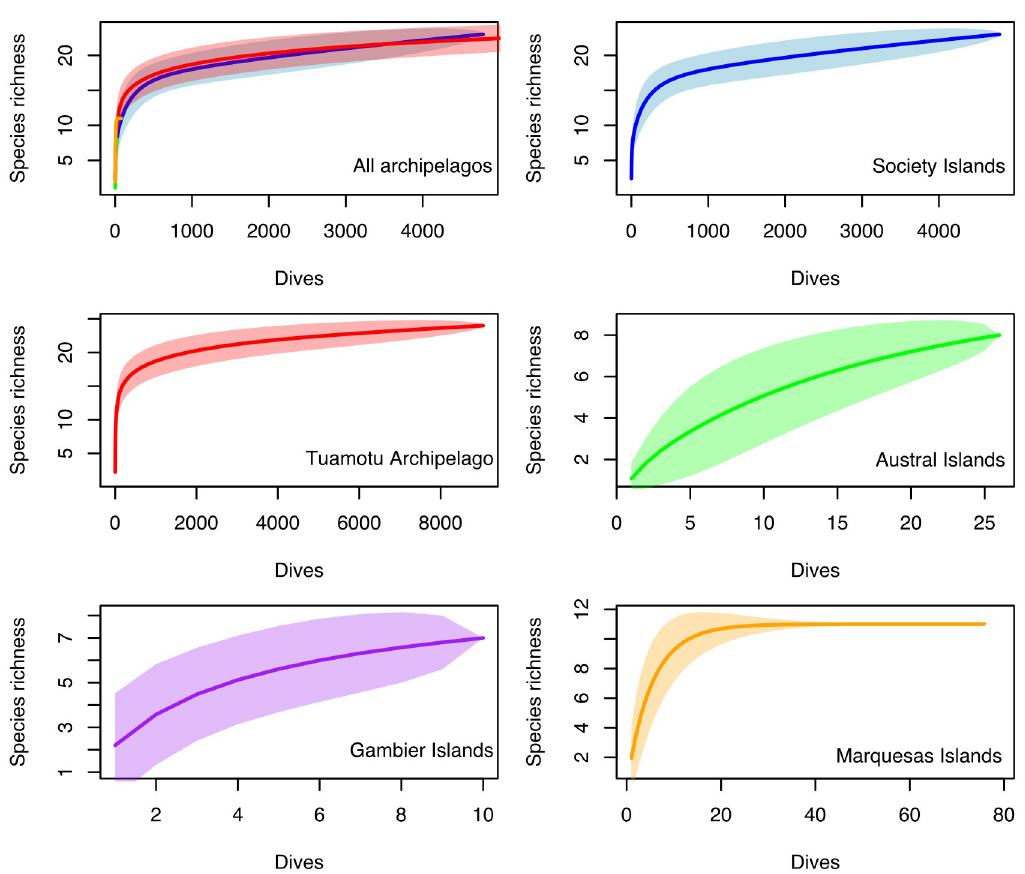
Fig 4. Evolution of species richness on the different archipelagos of French Polynesia as a function of the number of cumulative dives in the area. 95% confidence intervals are highlighted for each graph.